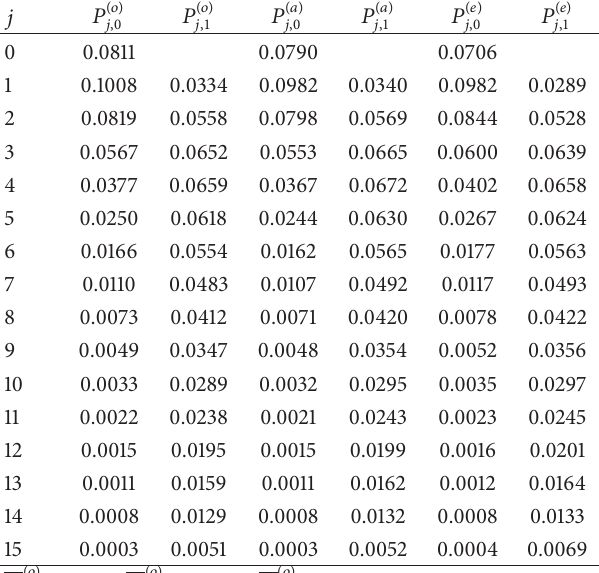
Table 2: System queue length distribution at various epochs when service time is arbitrary with {𝑔 (𝑏)